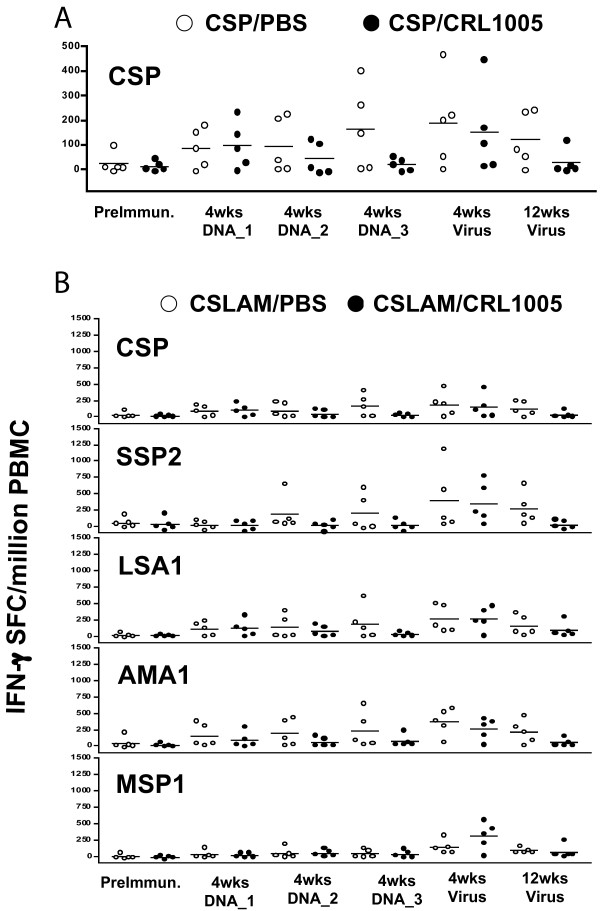
Effects of CRL1005 formulation on the magnitude of IFN-γ ELIspot responses in (A) PfCSP/PBS versus PfCSP/CRL1005 or (B) CSLAM/PBS versus CSLAM/CRL1005 immunized monkeys. Monkeys were immunized with either PfCSP or CSLAM in PBS (open circle) or formulated in CRL1005 (solid circle). PBMC were collected at time points as defined in the legend to Figure 2 and assayed against recombinant PfCSP, PfLSA1, PfAMA1 or PfMSP1 protein and PfSSP2/TRAP peptide pools by IFN-γ ELIspot. Data represent the magnitude of IFN-γ responses specific for PfCSP, PfSSP2/TRAP, PfLSA1, PfAMA1 or PfMSP1, for each monkey.